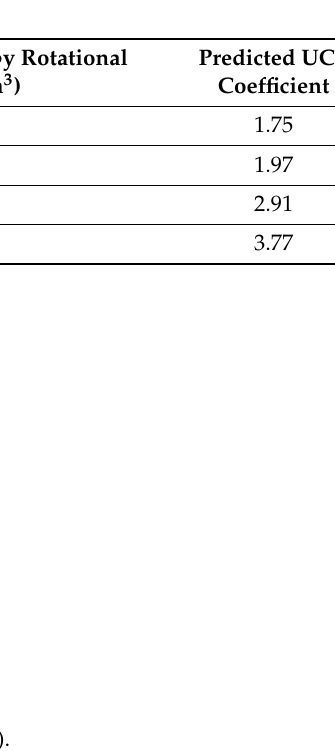
Figure 11. Speed chart of the rock drilling experiment.